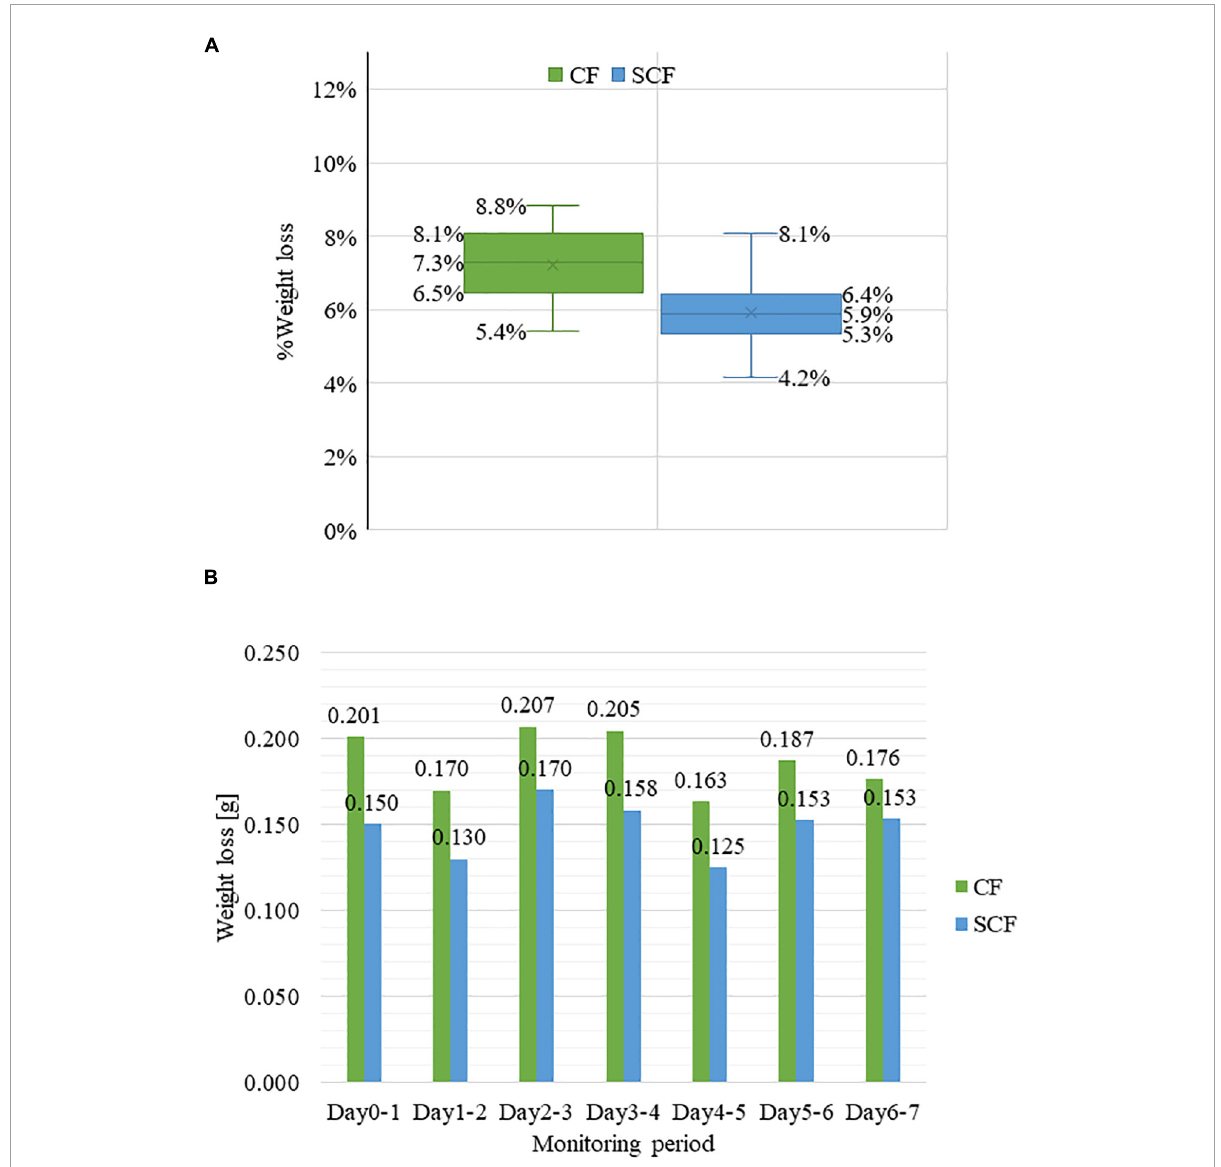
FIGURE2 Weight loss during the storage. (A) % weight loss of strawberry samples in control fridge (CF) and supercooling fridge (SCF) after 7 days of storage (B) the daily weight change of the strawberry samples in CF and SCF conditions within 7